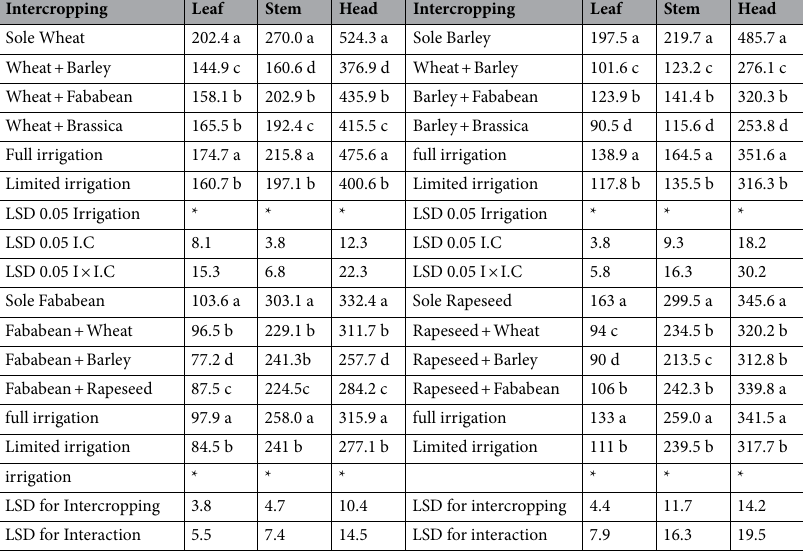
Table 3. Dry matter partitioning (g m −2 ) at physiological maturity of winter crops as affected by intercropping and irrigation regimes.